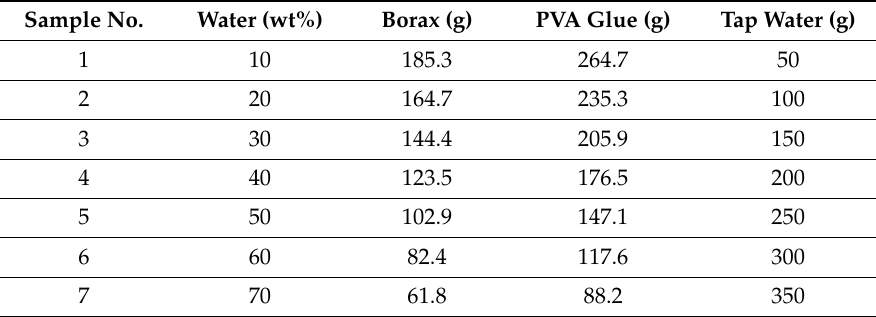
Table 1. Ingredients of seven types of samples (for 500